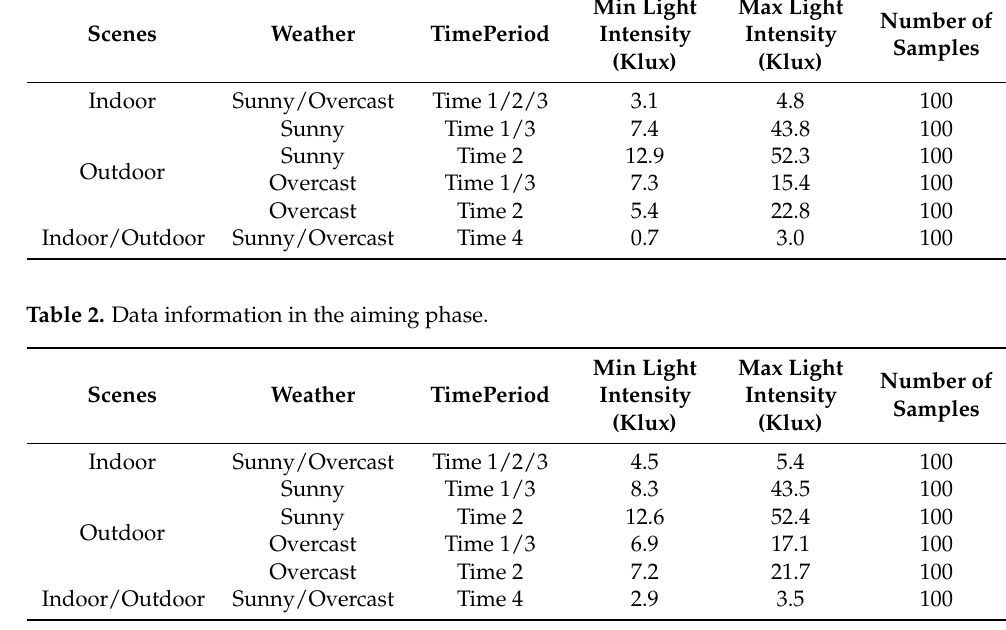
Figure 2. Plug-in experiment platform.